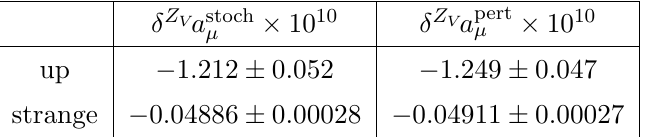
Table 7 . The QED correction to a (cid:22) due to the QED correction to the multiplicative renormalization Z V for the local-vector